Question: Provide a publication-style caption for this figure.
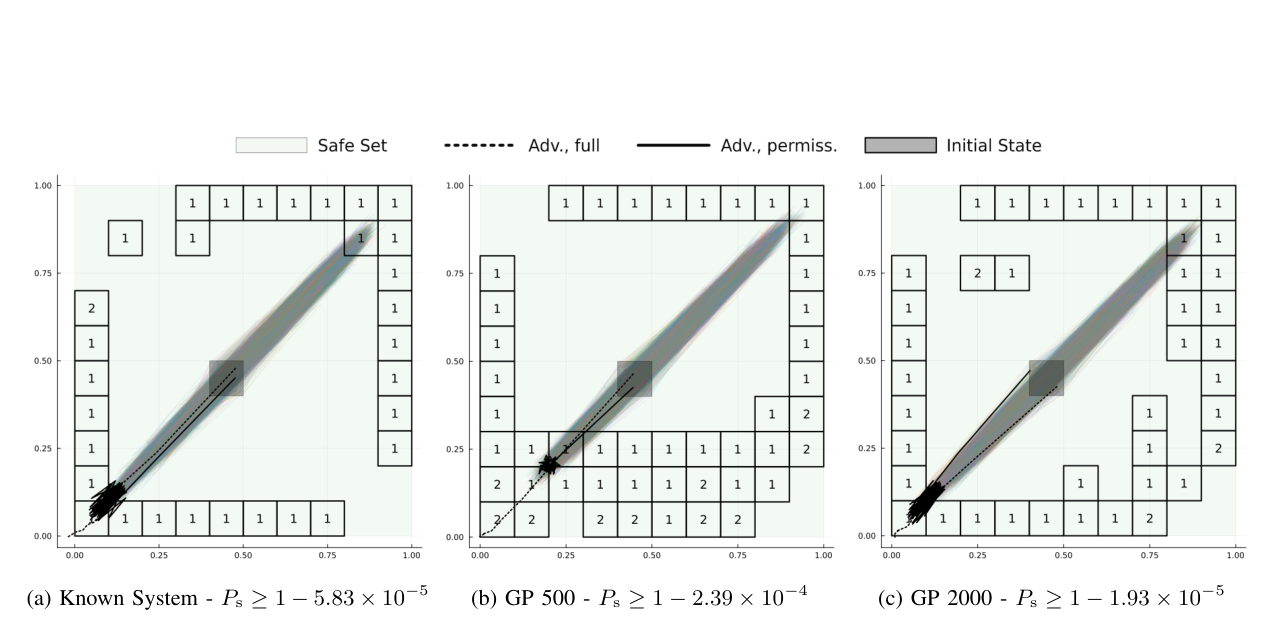
Answer: Results for the linear system case studies using the known system and two datasets. Regions with # of removed control regions and simulated trajectories over 100 steps are shown in each plot. Adversarial trajectories show permissible sets maintain safety.